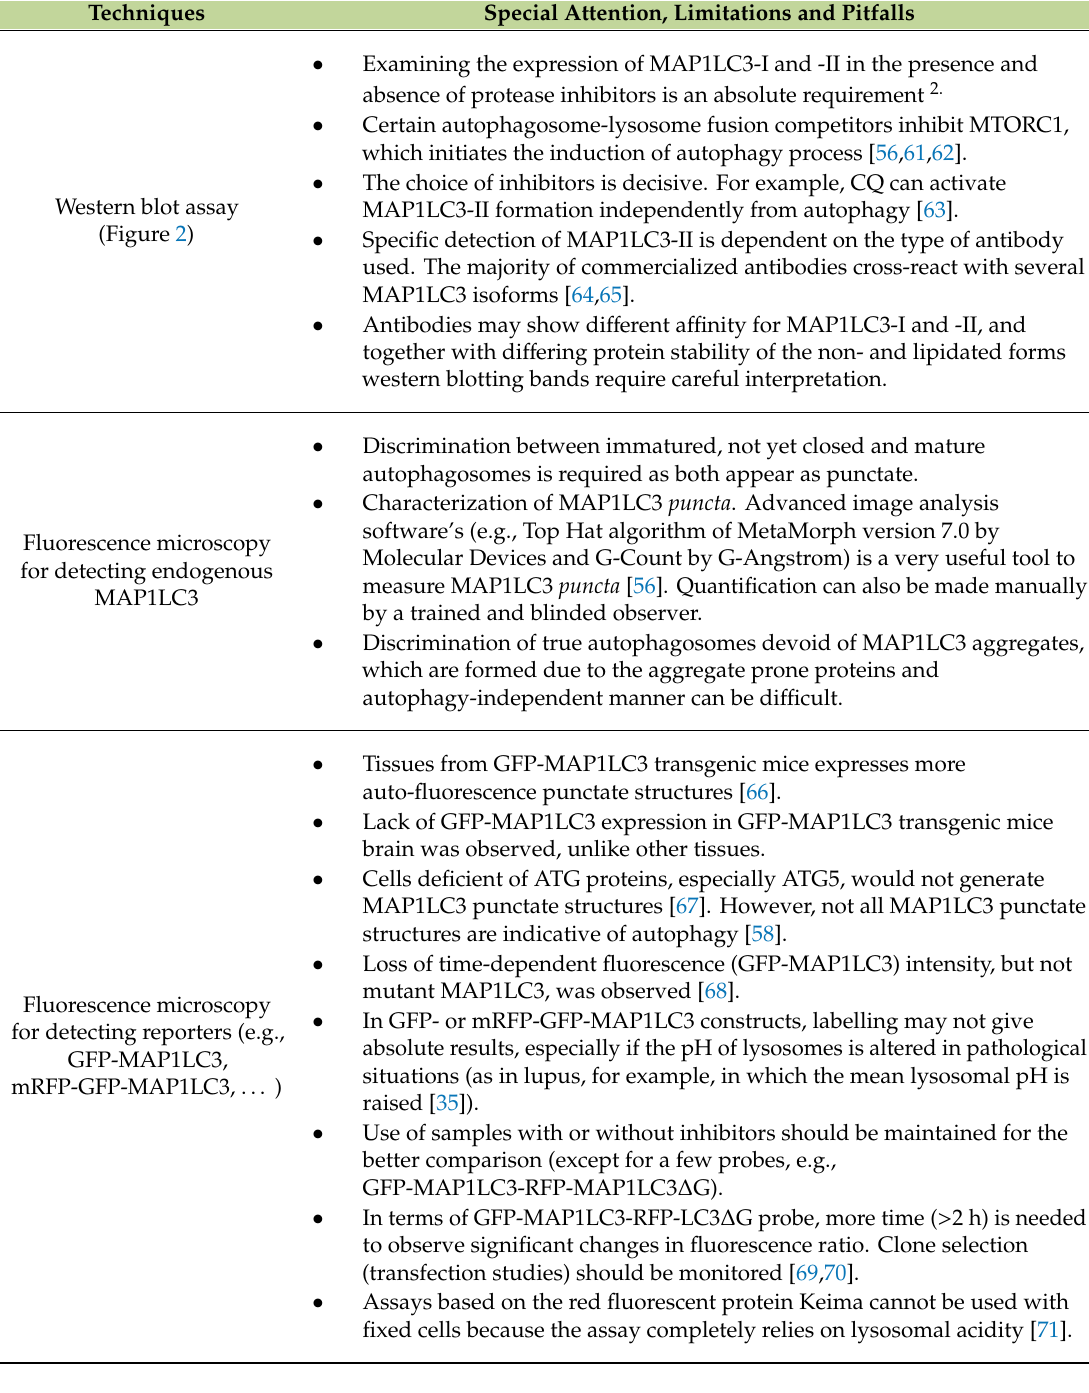
Table 2. MAP1LC31-based standard assay for assessing autophagy and their limitations 1